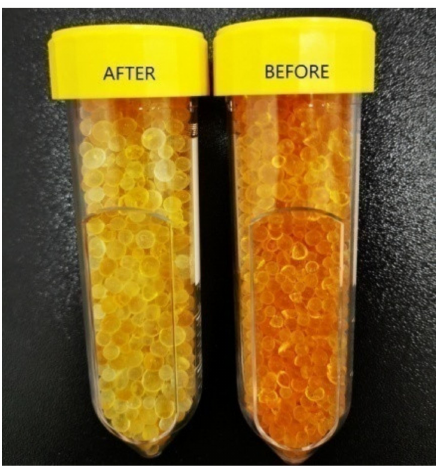
Figure 9. Picture representing the SiO 2 orange pearls after the interaction with a breath sample and before the interaction with a breath sample (color change from orange—before: right to colorless— after: